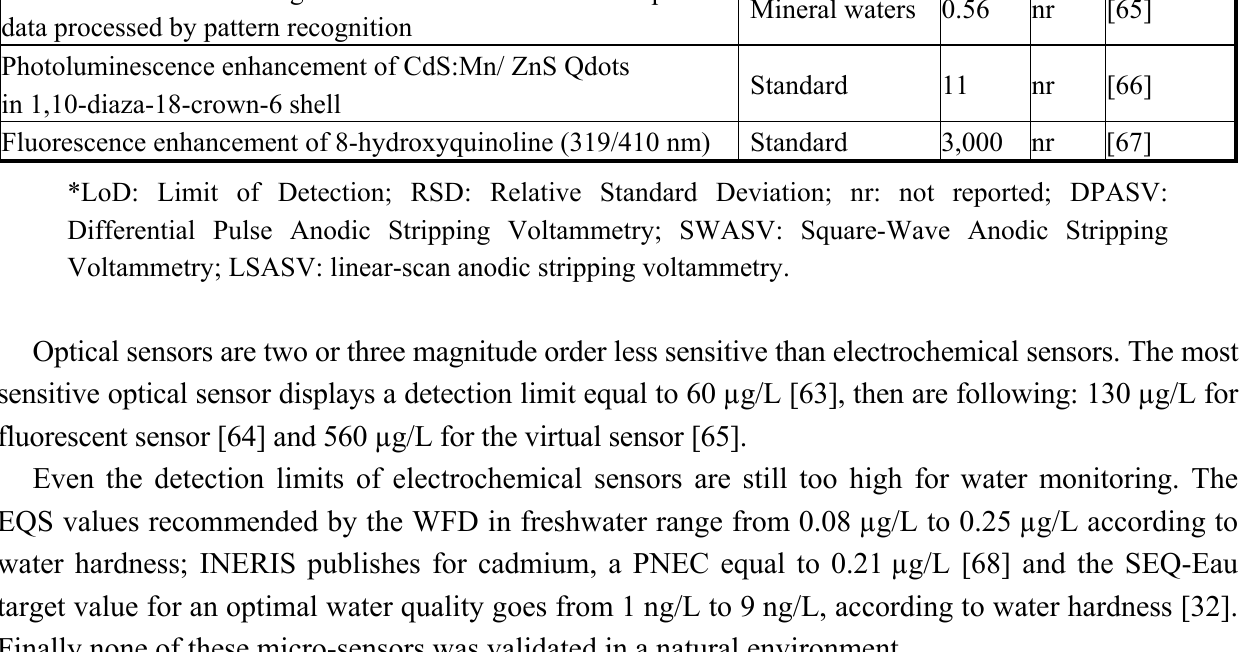
Table 3. Analytical characteristics of optical sensors for cadmium determination in water, published between 2007 and 2009. Method Tested sample Absorbance of 4-hydroxy salophen on triacetyl cellulose membrane at 431 nm